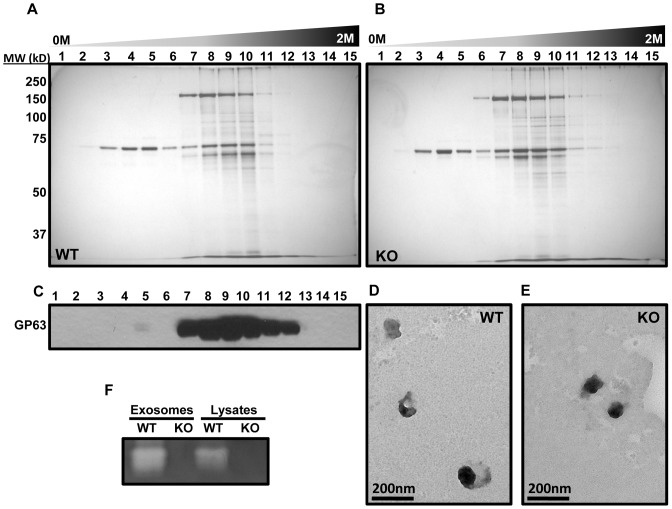
Purification of exosomes from CM of WT and KO parasites.A and B. Silver stainings of sucrose density gradient fractions of WT and KO exosomes respectively. Enrichment of bands can be observed in fractions 8, 9 and 10, which correspond to the density of exosomes. C. Western blotting of sucrose density gradient fractions of WT exosomes against GP63. Again accumulation of GP63 can be observed at fractions 8, 9 and 10. D and E. Transmission electron microscopy of WT and KO exosomes shows that WT and KO exosomes have similar size and morphology. Arrows point to exosomes. F. Gelatin zymogram of 3 µg of exosomes and lysates shows that GP63 remains active after exosome purification. All results are representatives of at least 3 independent experiments.